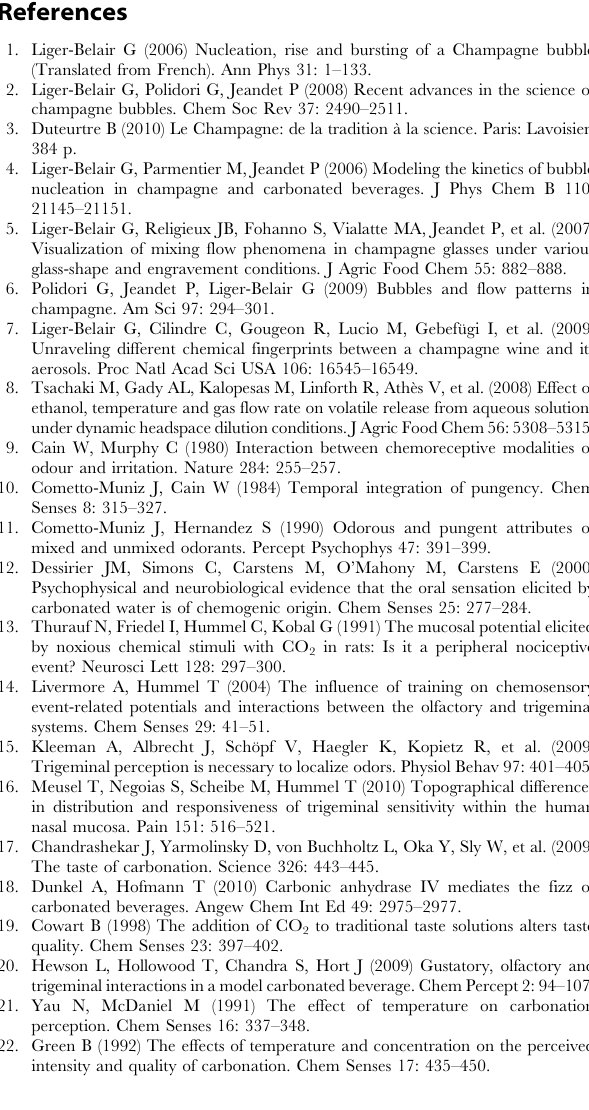
Table S1 Listing of the chromatographic parameters used for the simultaneous analysis of CO 2 and ethanol above the free surface of champagne glasses (redrawn from [ 39 ]